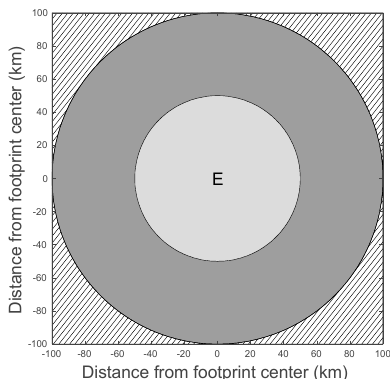
Figure 2. Schematic view of the weighting of the satellite measurement for Aquarius whose footprint size is ~100 km [3]. The estimate is made at the central point, ‘E’. The footprint (Figure 1; also see locations in Figure 3), is the light gray area from which half of the information to obtain the estimate is taken. The dark gray area is that from which ~44% of the information is taken. Outside the dark gray area, part of which is hatched in this figure, contains about 6% of the information.